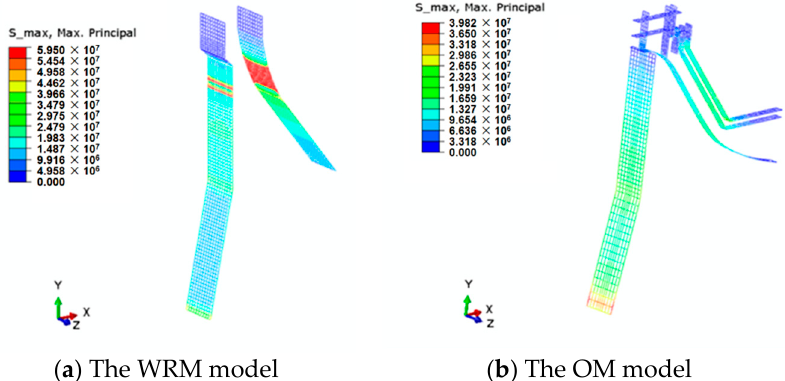
Figure 15. The maximum tensile stress on the SR of Huangdeng dam.